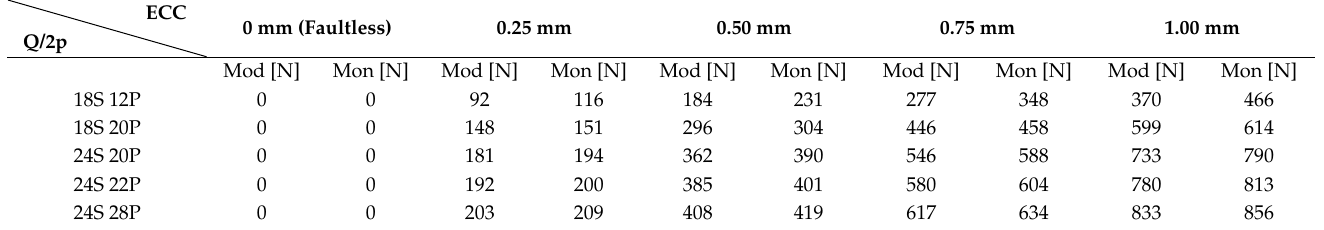
Table 4. Average UMF of different PMSM and MPMSM slot/pole combinations in the presence of